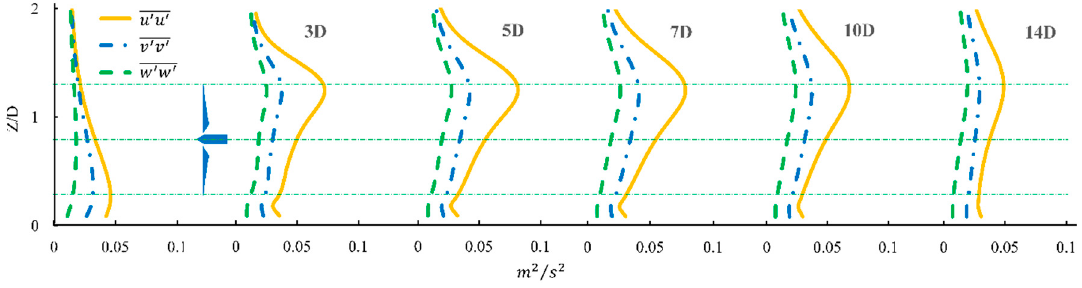
Figure 17. Horizontal distribution of (cid:1873) (cid:4593) (cid:1873) (cid:4593) (cid:3364)(cid:3364)(cid:3364)(cid:3364)(cid:3364)(cid:3364) , (cid:1874) (cid:4593) (cid:1874) (cid:4593) (cid:3364)(cid:3364)(cid:3364)(cid:3364)(cid:3364)(cid:3364) and (cid:1875) (cid:4593) (cid:1875) (cid:4593) (cid:3364)(cid:3364)(cid:3364)(cid:3364)(cid:3364)(cid:3364)(cid:3364) simulated by RSM.